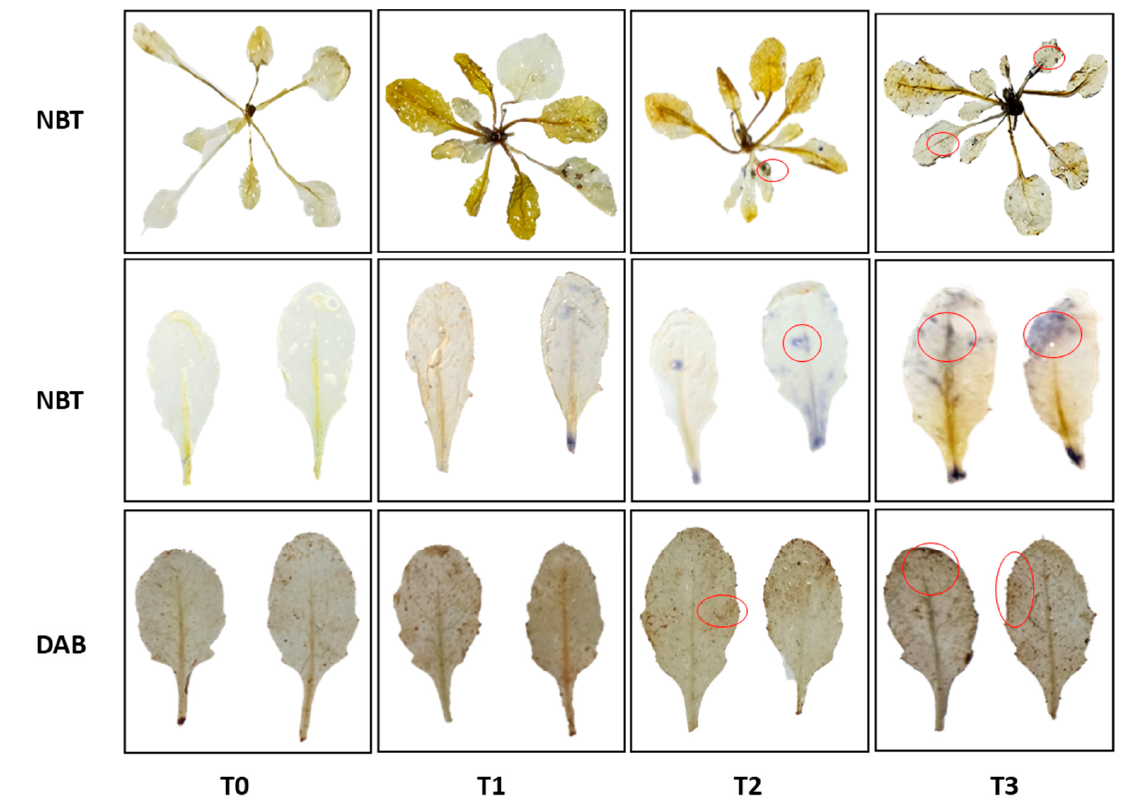
Figure 5. The effects of rohitukine concentrations on T0 (control), T1 (0.25 mM), T2 (0.5 mM) and T3 (1.0 mM) as detected through histochemical detection of ROS in A. thaliana leaves. Superoxide ions were detected with NBT staining dye; the H 2 O 2 visualization in leaves was performed via DAB staining.